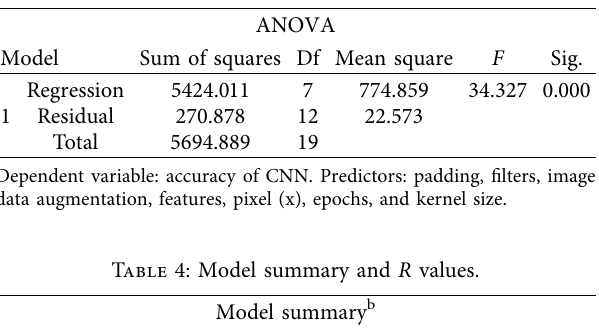
Table 3: ANOVA regression output.